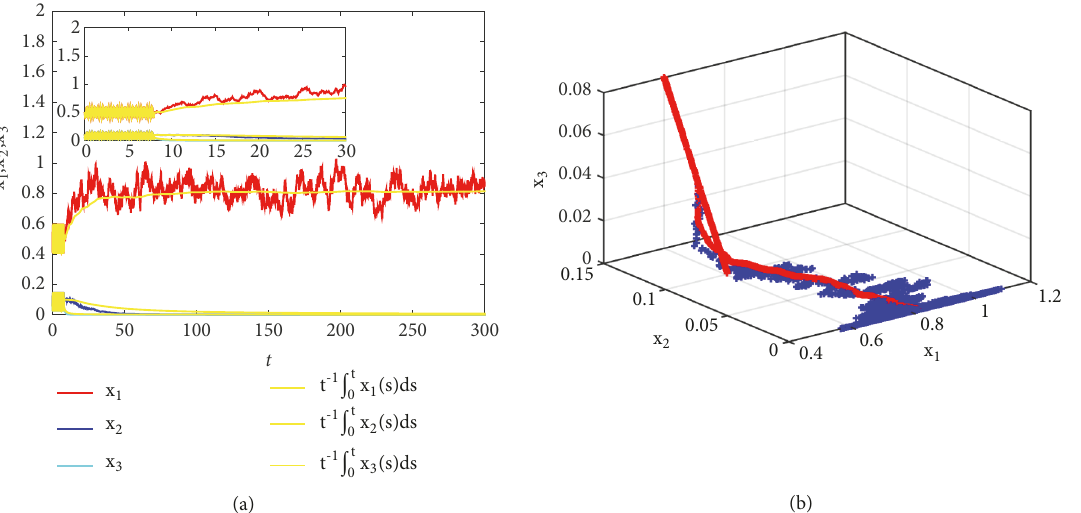
Figure 2: One prey persistent in mean and others are extinct as given in Theorem 11. (b) stands for the phase portrait of (a). The density of white noises is taken: 𝜎 1 = 0.5 , 𝜎 2 = 22 , 𝜎 3 = 30 .